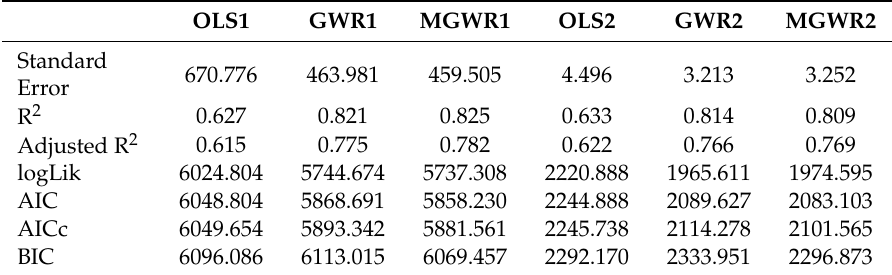
Table 8. Basic diagnostic statistics of OLS, GWR and MGWR models.